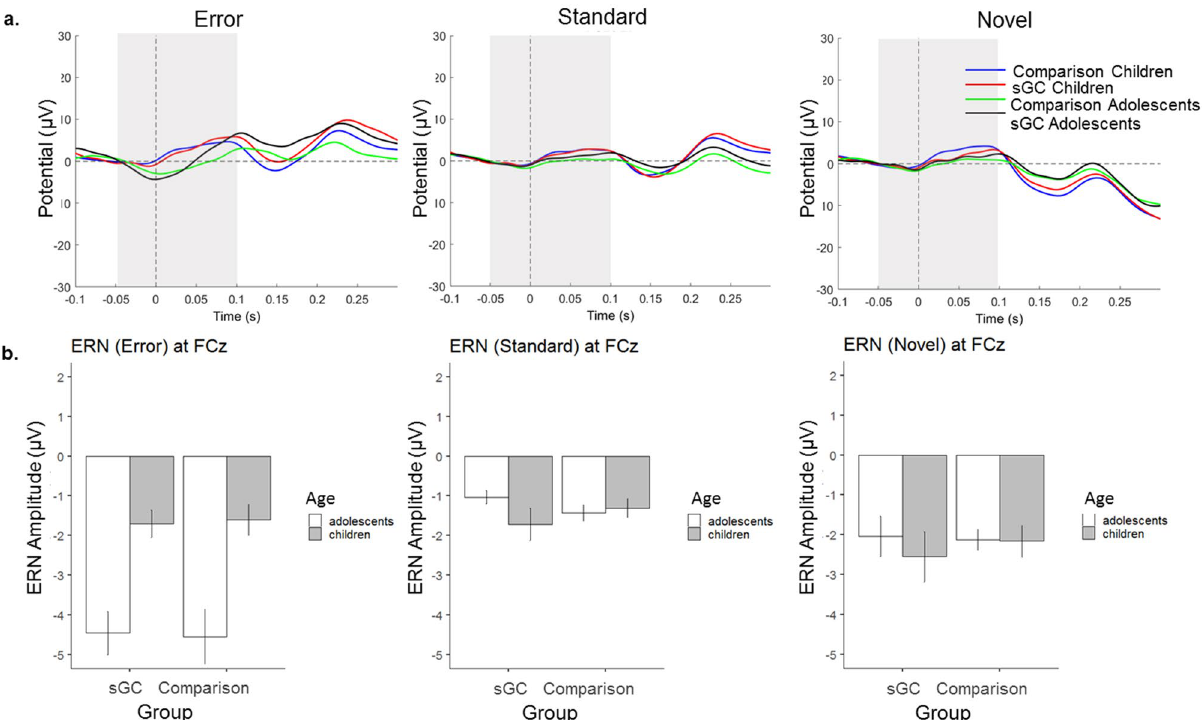
Figure 5. ( a ) Grand averaged ERP waveforms at FCz for Novel, Standard and Error stimuli, ( b ) Interaction between Age and Stimuli on ERN amplitude (Error bars represent ± 1 standard error of mean).